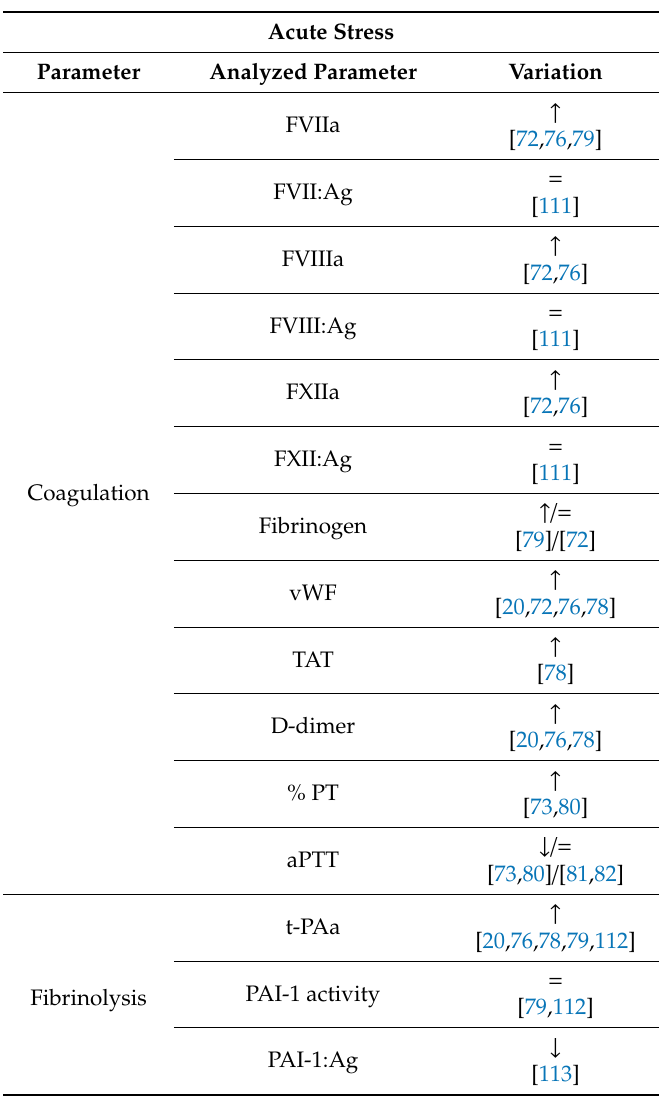
Table 2. Alteration of coagulation and fibrinolysis factors caused by acute